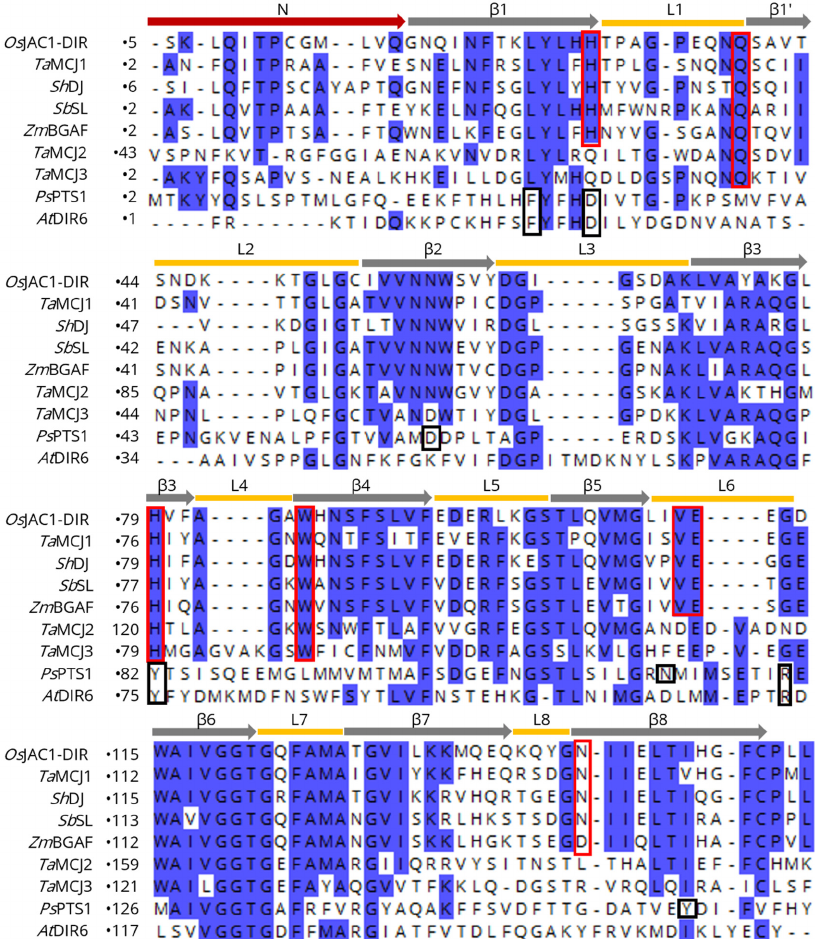
Figure 3. Sequence alignment (CLUSTAL OMEGA multiple sequence alignment [47] ) of the Os JAC1 ‐ DIR domain with different MCJ and DIR proteins. Yellow bars correspond to the loops, grey arrows to the β‐ strands, red arrow to the N ‐ terminal regions of the Os JAC1 ‐ DIR domain; the carbohydrate binding residues described in this work are highlighted by red frames. Black frames indicate residues of the active site in Ps PTS1 [20] . Conserved regions (>50% identity) are shaded in blue. The sequences correspond to proteins from Triticum aestivum ( Ta MCJ1, ‐ 2, ‐ 3), Saccharum hybrid ( Sh DJ), Sorghum bicolor ( Sb SL), Zea mays ( Zm BGAF), Picea sitchensis ( Ps PTS1), and Arabidopsis thaliana ( At DIR6).